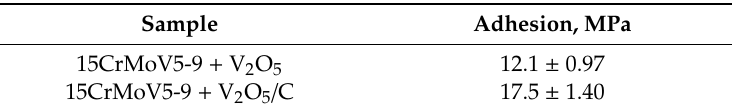
Table 2. Characteristics of the adhesion of the sample.